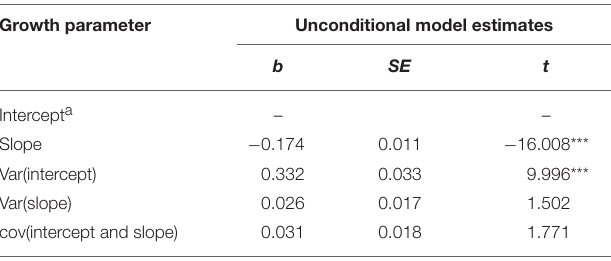
TABLE 4 | Results of the unconditional latent growth model for the trajectory of conduct problems. Growth